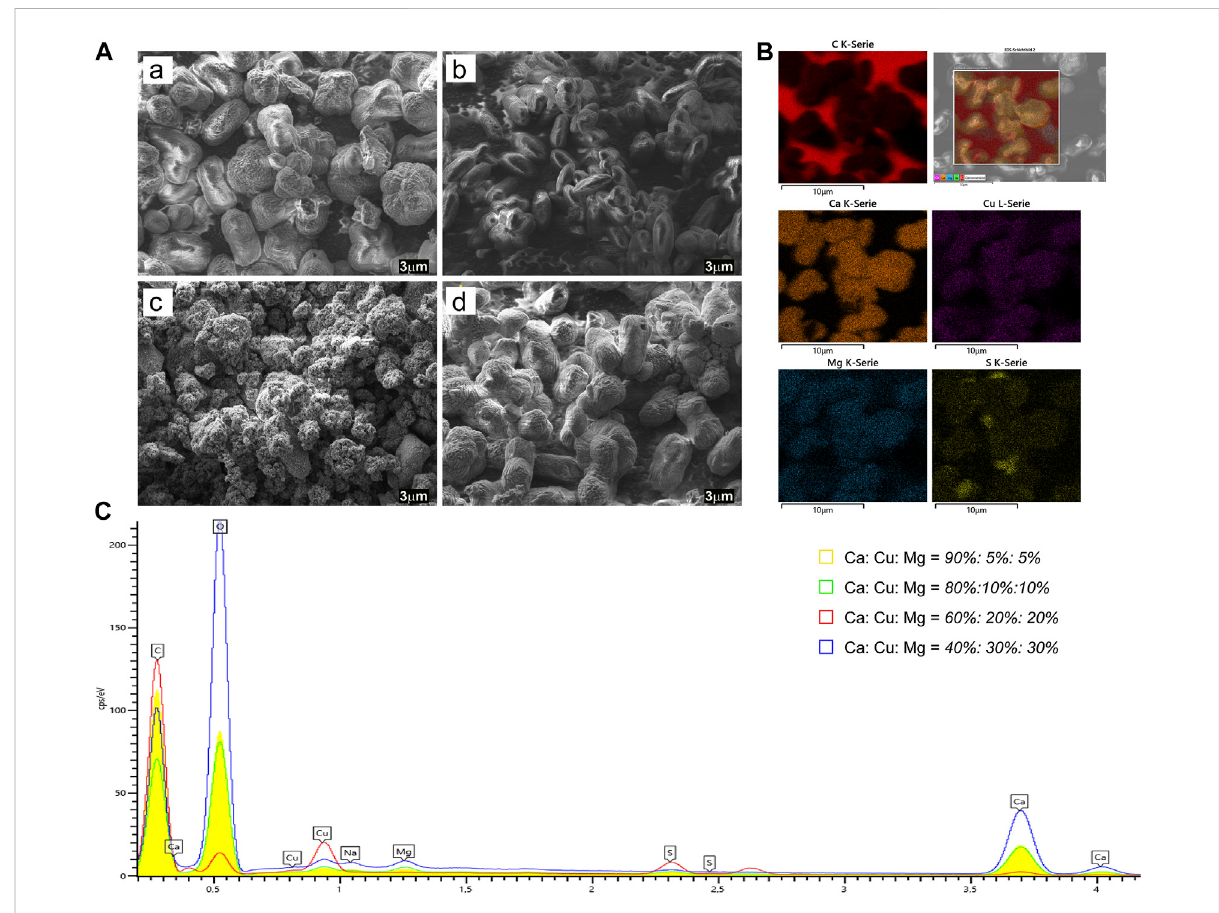
FIGURE 3 (A) SEM images of CaCuMg-PEM-Col microcapsules prepared with different ratios of salts: (a) Ca 2+ : Cu 2+ : Mg 2+ = 90%: 5%: 5% , (b) Ca 2+ : Cu 2+ : Mg 2+ = 80%: 10%: 10% , (c) Ca 2+ : Cu 2+ : Mg 2+ = 60%: 20%: 20% , (d) Ca 2+ : Cu 2+ : Mg 2+ = 40%: 30%: 30% (scale bar = 3 μ m). (B) C, Ca, Cu, Mg, S